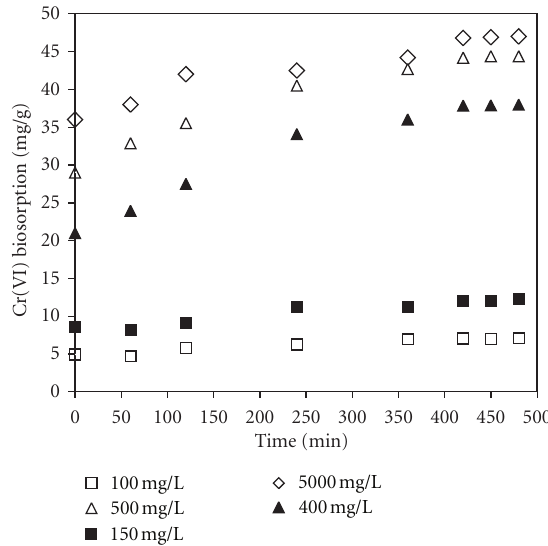
Figure 2: Time course for Cr(VI) removal by biosorption using T. gamsii biomass from electroplating industrial waste, diluted to a final Cr(VI) concentration of 100mg/L.